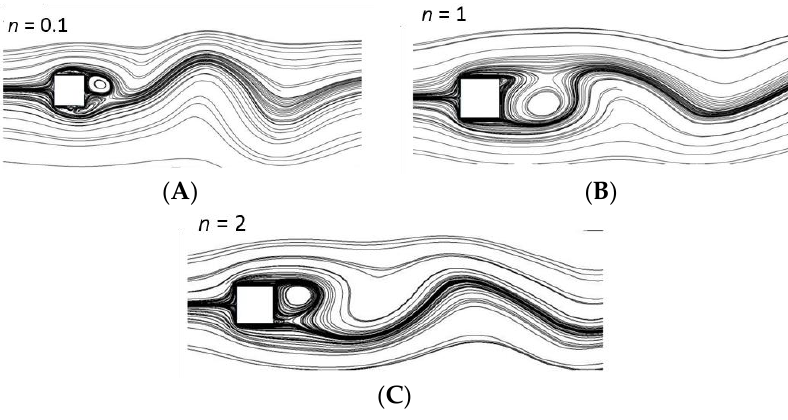
Figure 11. Instantaneous streamlines for Re = 100 and ( A ) n = 0.1, ( B ) n = 1, and ( C ) n = 2.